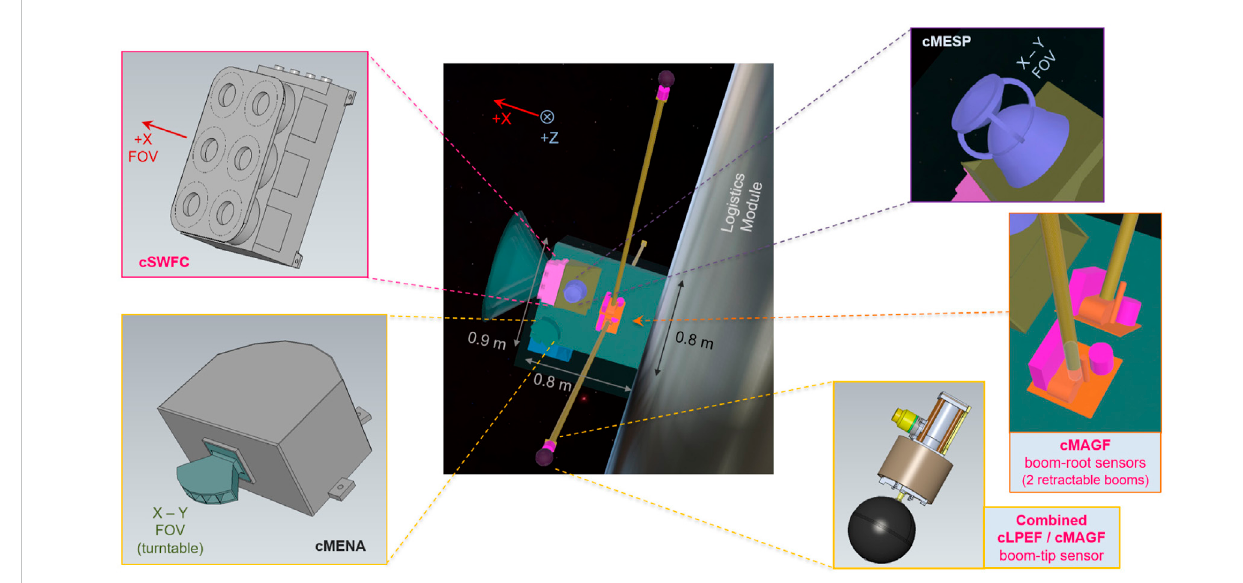
FIGURE 18 Main Instrument Platform – Z side, with all booms deployed.